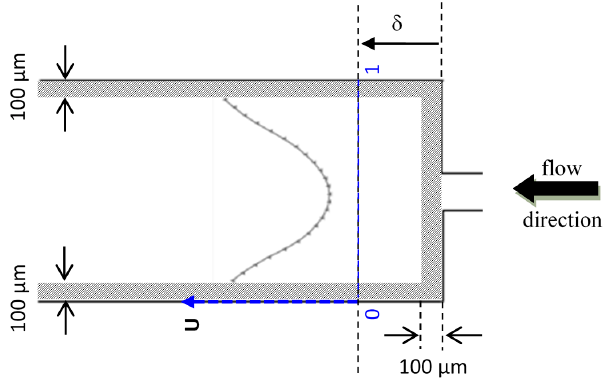
Figure 6. Schematic diagram of the contraction-expansion micro-channel, showing the plot of a mean axial velocity profile at a distance δ downstream of the contraction. Data in the shaded region has been removed due to high noise level.